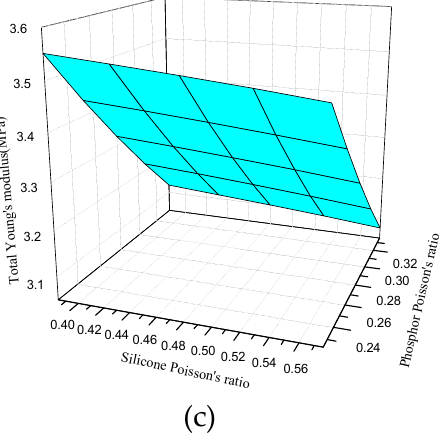
Figure 14. A sensitivity study on the Young’s modulus of phosphor/silicone composites ( a ) density; ( b ) Young’s modulus; ( c ) Poisson’s ratio.